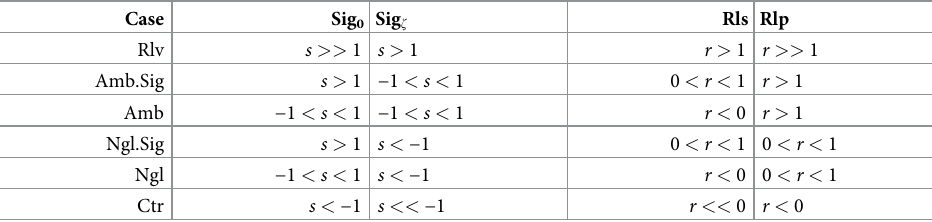
Table 1. Classification of cases defined by ranges of significance and relevance measures. s and r are the place hold- ers for the column headings.